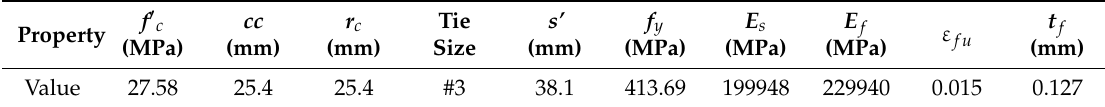
Table 12. Common properties for the parametric study.